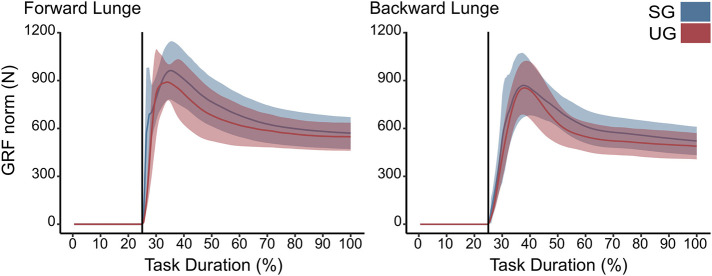
Euclidean norm of the ground reaction force (GRF) during forward and backward lunges from lift-off until steady state. Each panel show the mean values and standard deviation bands for the stable (SG—blue) and unstable ground conditions (UG—red). Both panels are presented in a time normalized base, vertical lines represent touchdown.